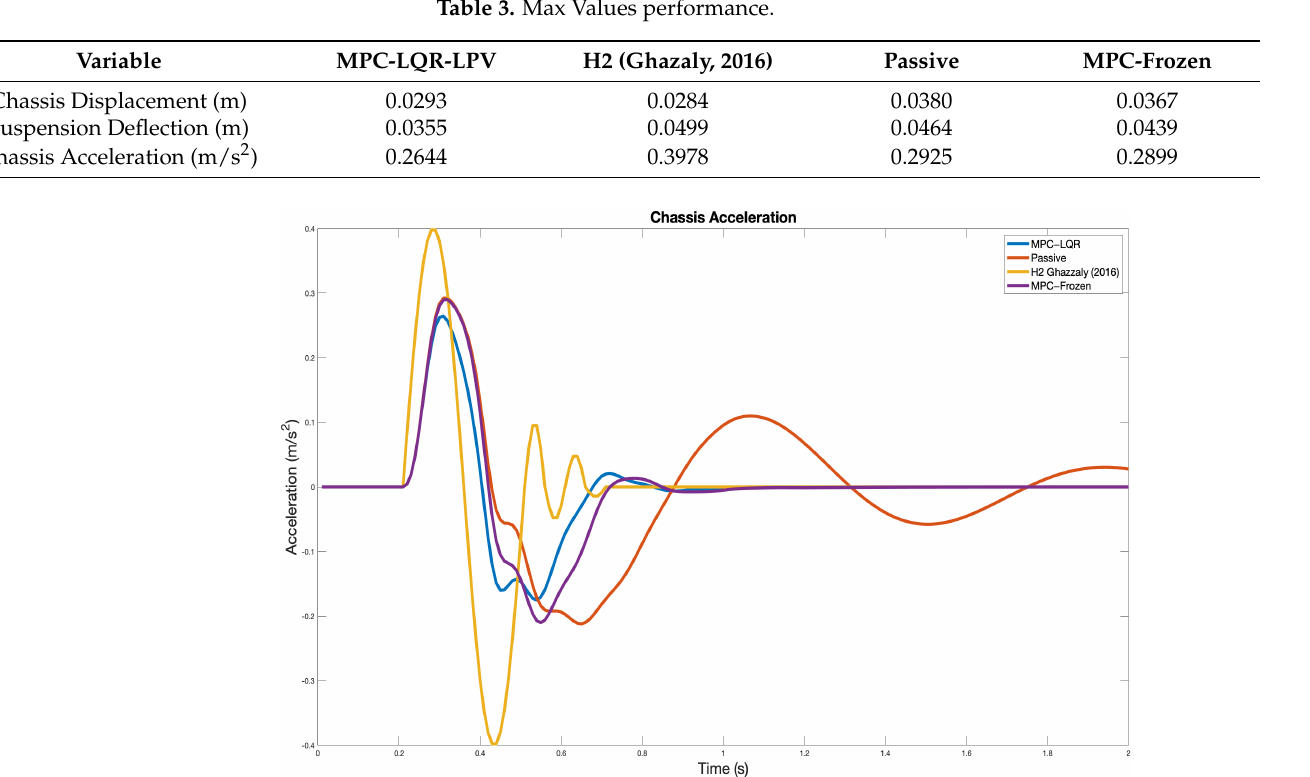
Figure 9. Chassis Acceleration—Bump disturbance (Blue—MPC-LQR, Red—Passive, Yellow—H2, Purple—MPC-Frozen).